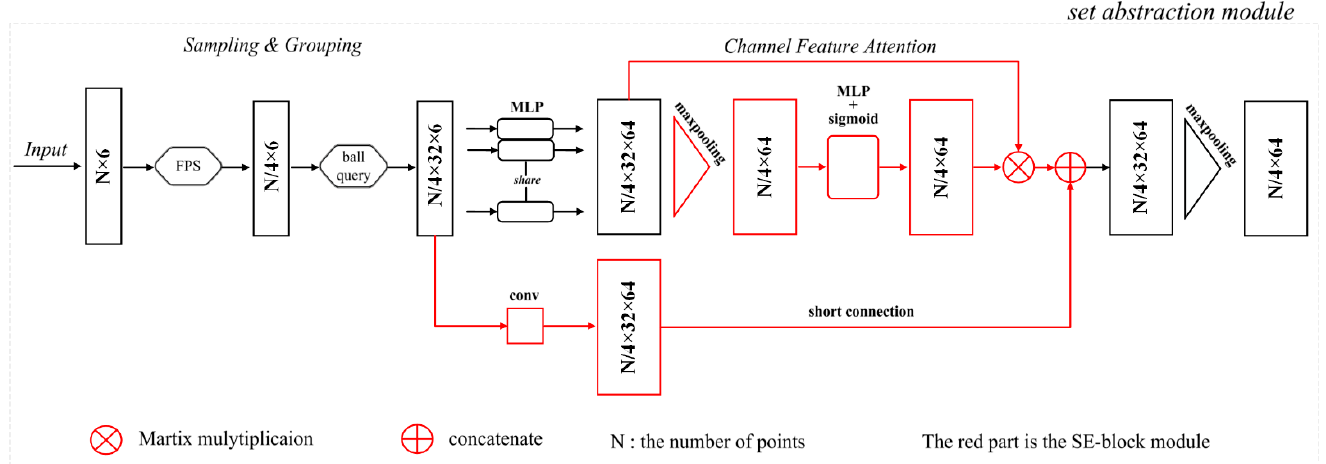
Figure 5. An illustration of the set abstraction module.